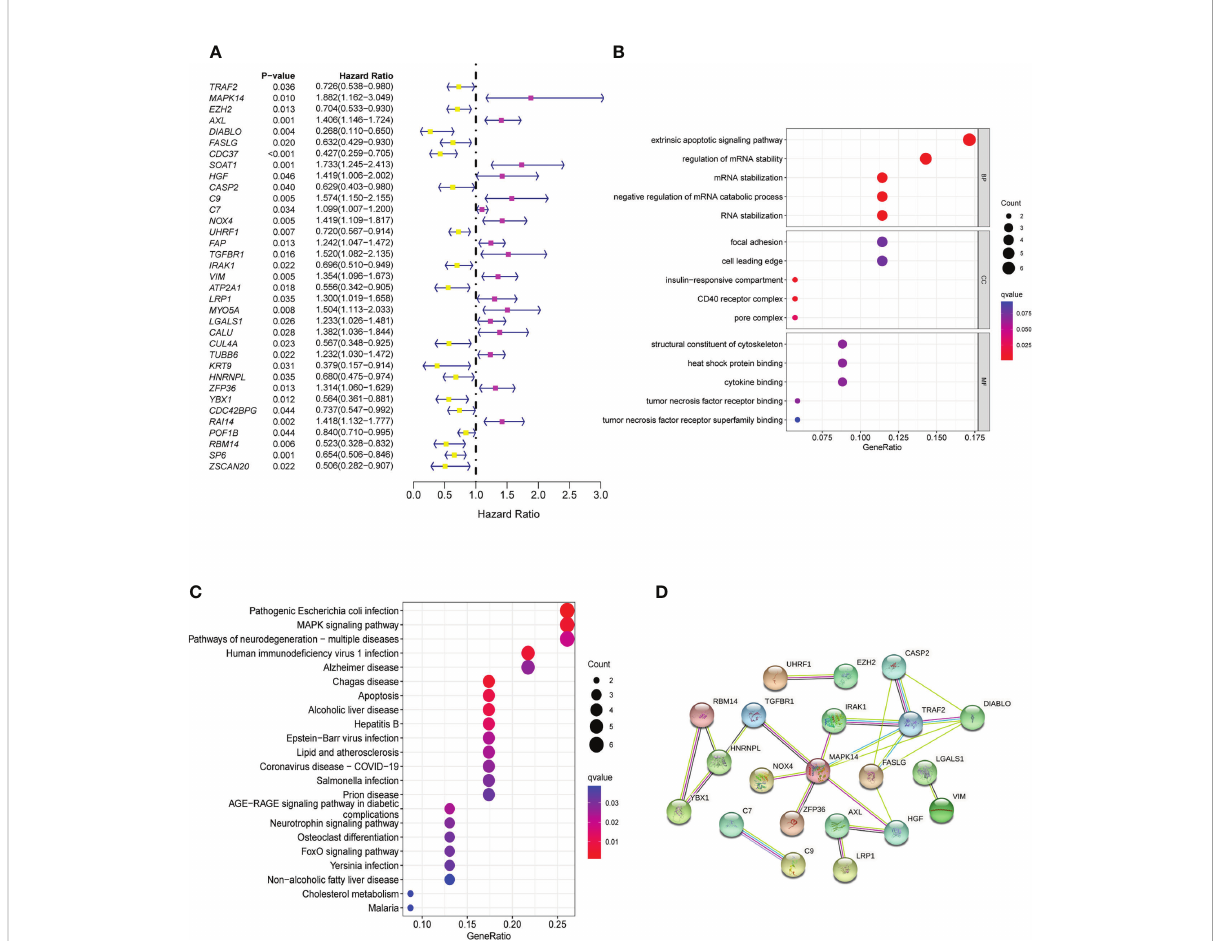
FIGURE 2 Identi fi cation and functional enrichment analysis of prognostic markers. (A) The forestmap of 35 prognostic markers of GC patients in the TCGA cohort. (B) The GO enrichment analysis of the prognostic markers. (C) The KEGG pathway analysis of the prognostic markers. (D) The PPI network was constructed through 35 prognostic markers. The interaction score was set to 0.4. GC, Gastric cancer; GO, Gene Ontology; KEGG, Kyoto Encyclopedia of Genes and Genomes; PPI, protein-protein